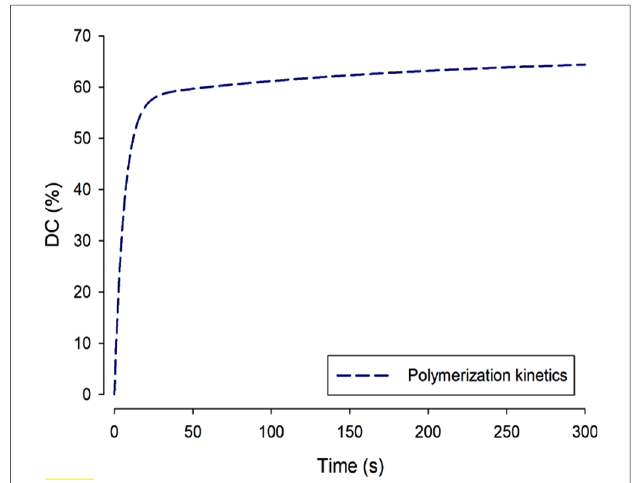
FIGURE 9 During dimethacrylate photopolymerization, as shown over a linear timescale, the degree of conversion normal increases rapidly and then — more slowly — approaches a maximum value: ca . 60%. Complete 100% conversion is not reached at oral temperatures because formation of the cross-linked network is increasingly a self-limiting process as the material converts from a mobile paste to a hard